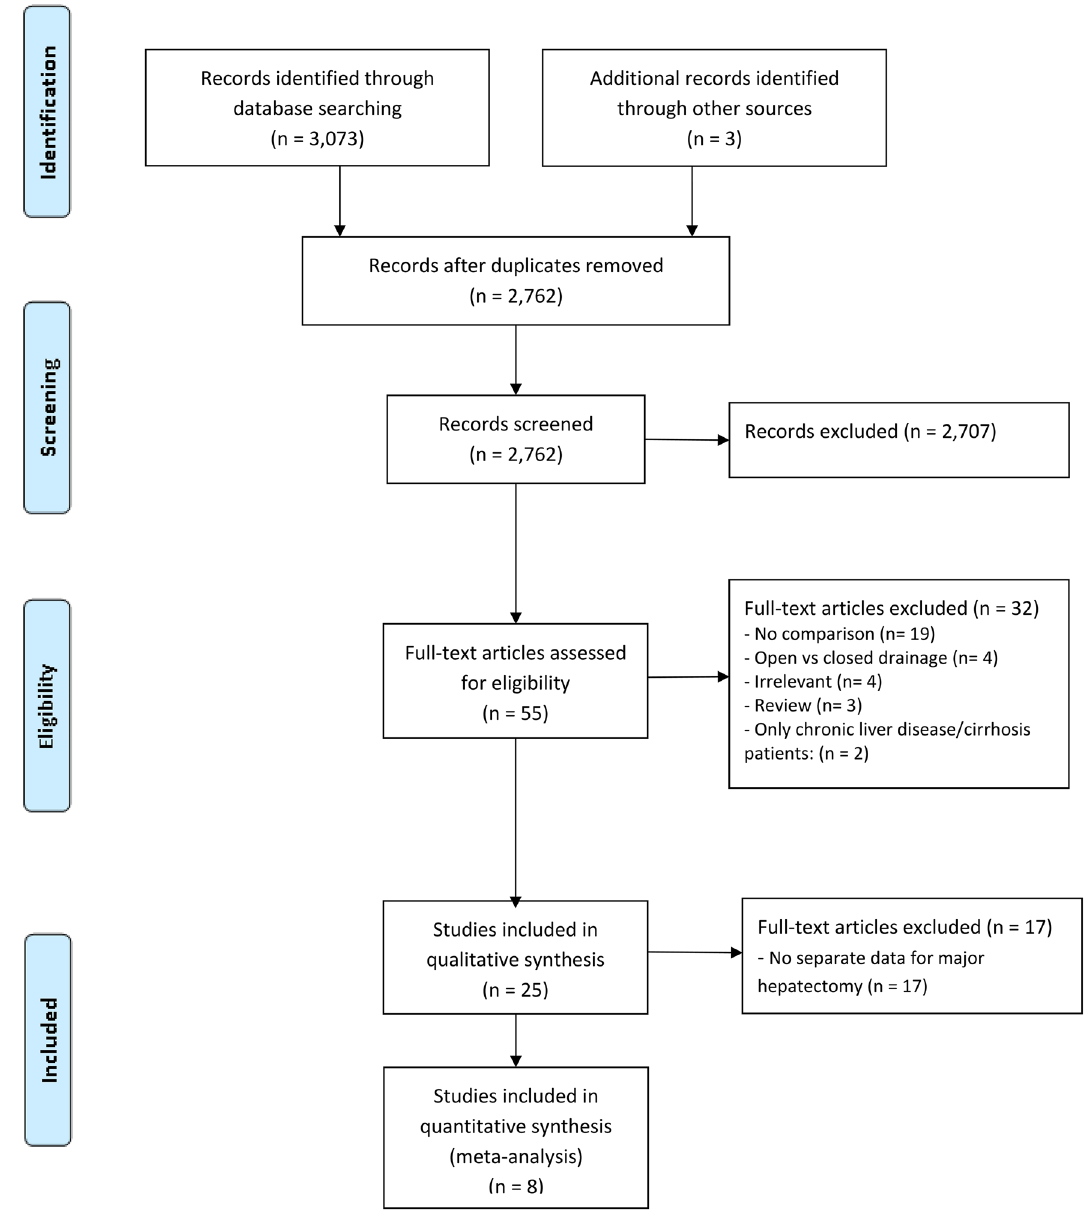
Figure 1. PRISMA flow chart of study